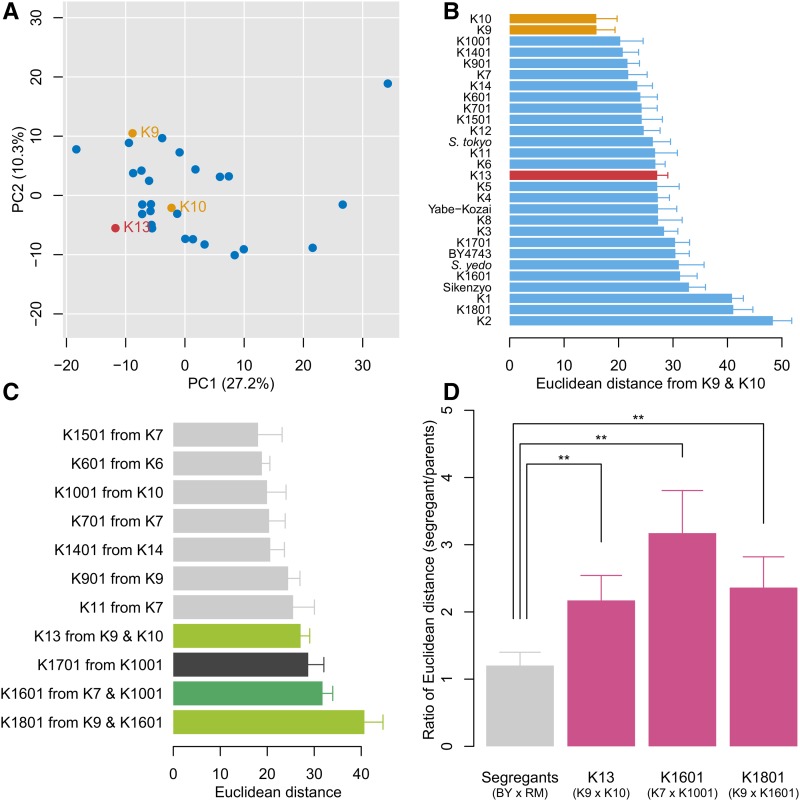
Morphological differentiation upon crossbreeding. (A) Distribution of phenotypes between parent strains and the hybrid strain. Orange and red circles indicate the parent strains (K9 and K10) and the hybrid strain (K13), respectively. (B) Distribution of Euclidean distance from the middle point between K9 and K10. The Euclidean distance was calculated from PC scores of 16 PCs (CCR = 90%). The color legends are the same as in (A). Error bars indicate SD. (C) Distribution of Euclidean distance from parent strains. The Euclidean distance was calculated from PC scores of 16 PCs (CCR = 90%). Dark and light green bars indicate hybrids generated with and without mutagens, respectively. Black and gray bars indicate other isolated strains with and without mutagens, respectively. Error bars indicate SD. (D) Morphological diversity of the segregants. Red and gray bars indicate the sake yeast strains and segregants from two distantly related yeast strains, BY and RM, respectively. The ratio of Euclidean distance (y-axis) was calculated by dividing the distance from the middle point of the parents to the progeny by that to the parents. Euclidean distance was calculated from PC scores that reached to 90% of CCR. Error bar indicates SD. ** P < 0.01 after Bonferroni correction by Wilcoxon–Mann–Whitney U-test (n = 62, 100, 125, and 125 in the segregants from BY × RM, K13, K1601, and K1801, respectively).